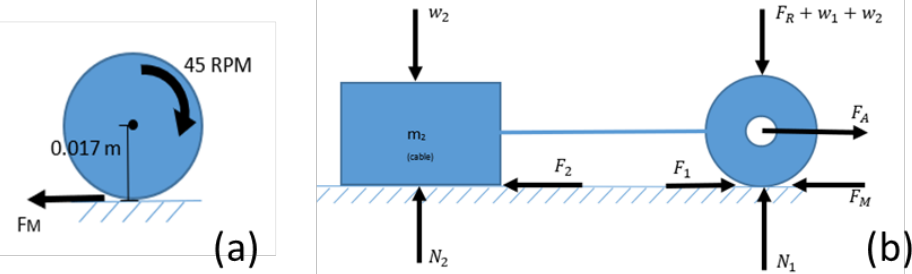
Figure 6. ( a ) Diagram to obtain the tangential force. ( b ) Force diagram to obtain the load the robots support.